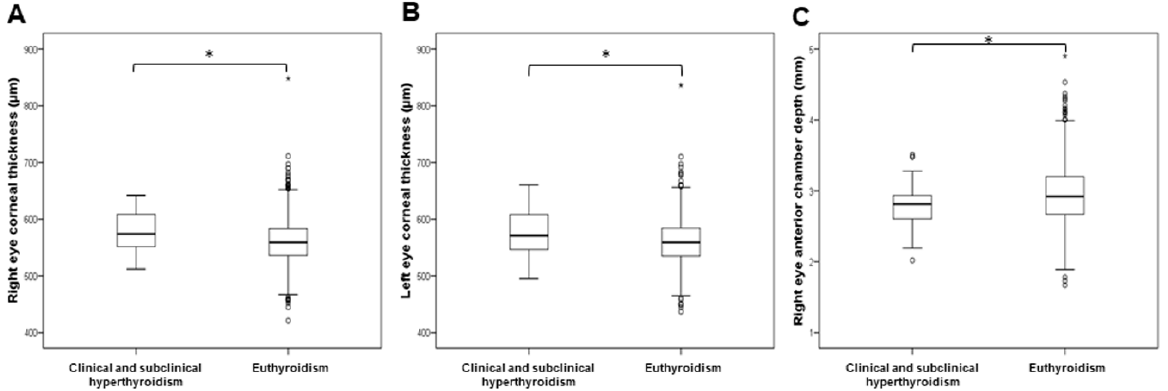
Figure 1. Comparison of ocular parameters between individuals with clinical or subclinical hyper- thyroidism and euthyroid individuals. ( A ) Right eye corneal thickness, ( B ) left eye corneal thickness, ( C ) right eye anterior chamber depth. * p < 0.05.